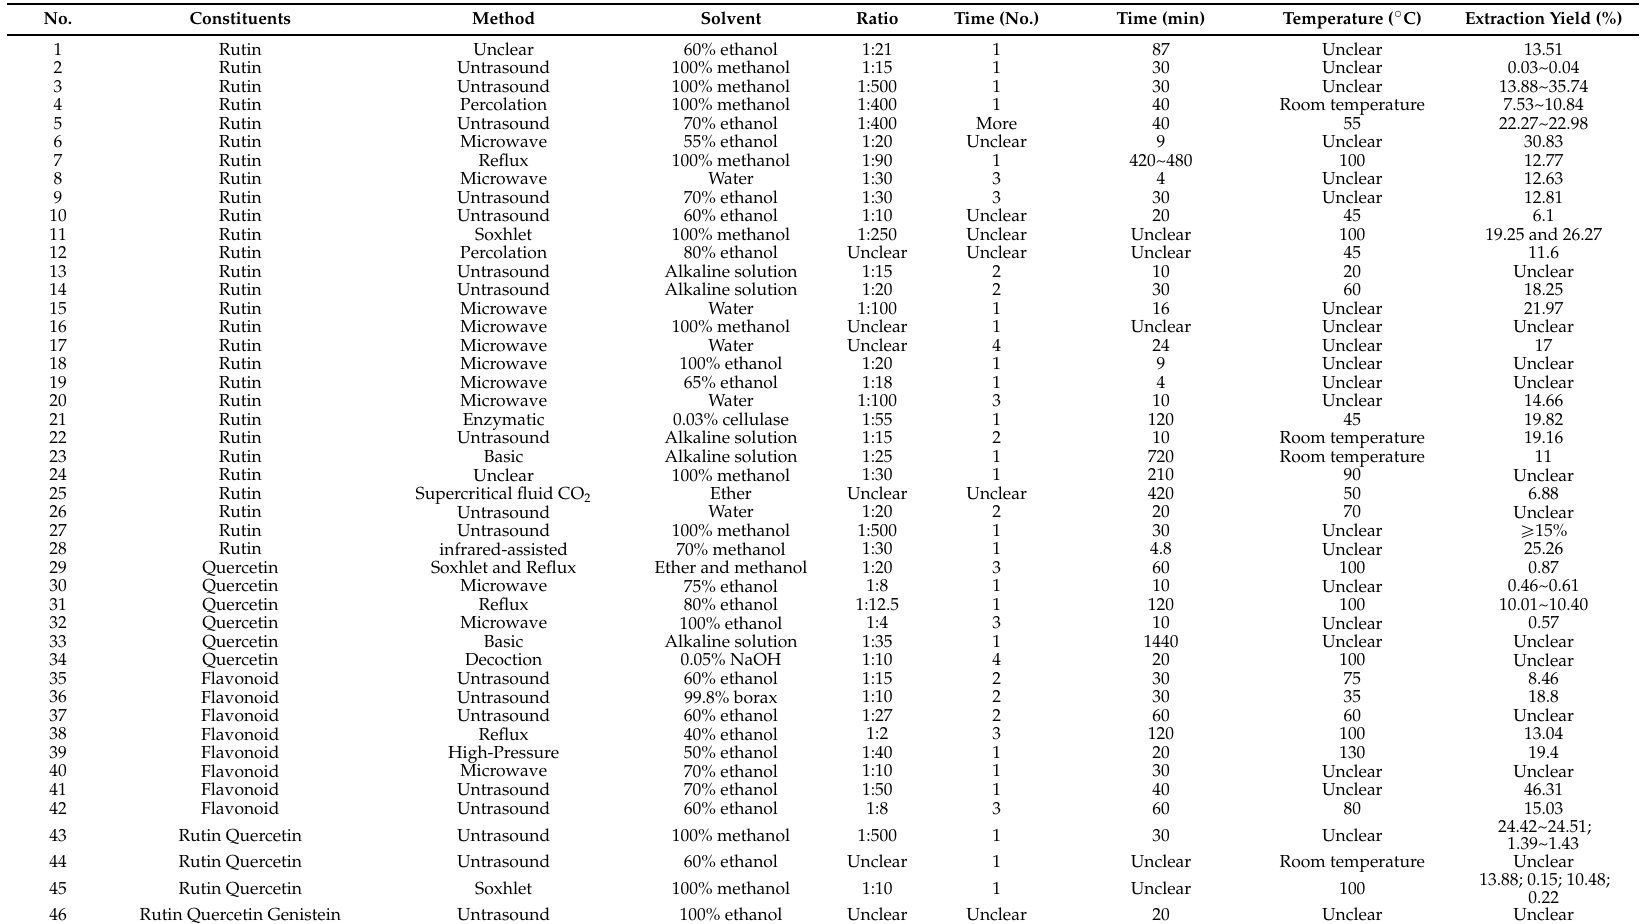
Table 1. Extracted conditions of different extraction methods in